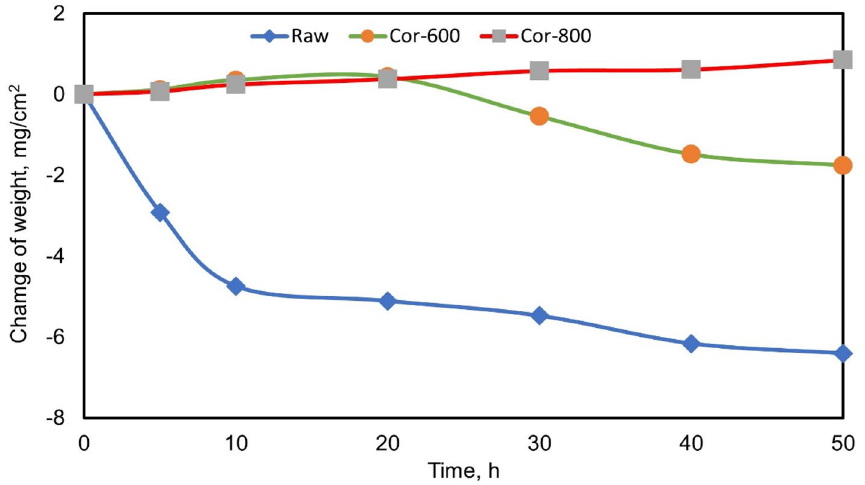
Figure 13. Variation of the weight of raw and oxidized (600 and 800 °C for 50 h) specimens after hot corrosion at 600 °C for 5, 10, 20, 30, 40, and 50